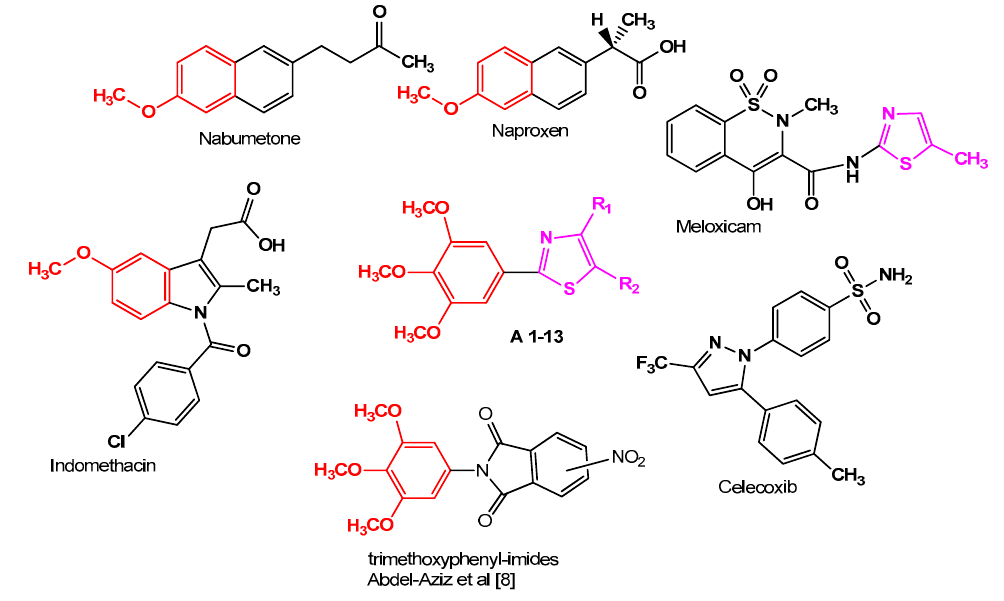
Figure 1. The inspiration for the design of the 2-(trimethoxyphenyl)-4-R1-5R2-thiazole scaffold.